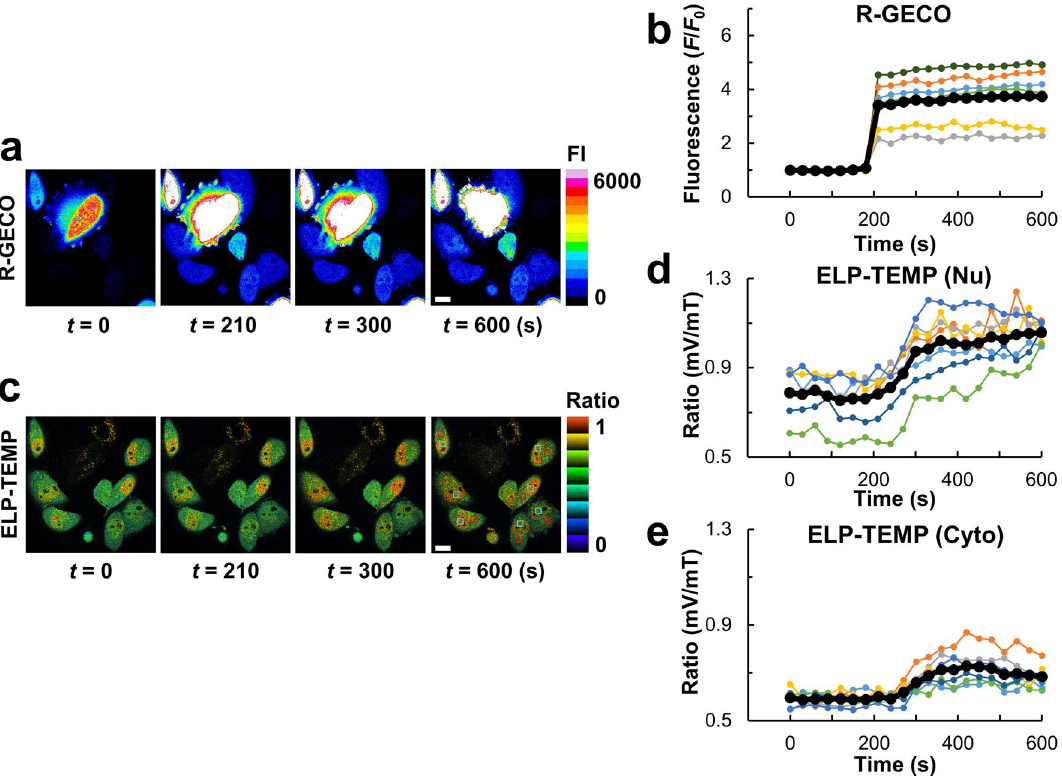
Figure 5. Visualization of heat production by stimulated Ca 2+ influx with a Ca 2+ -ionophore ionomycin in live HeLa cells stably expressing ELP-TEMP and transiently co-expressing R-GECO. ( a ) Pseudo-colored fluorescence images of R-GECO in response to ionomycin stimulation. ( b ) A plot of fluorescence intensity ( F / F 0 ) of R-GECO against time. ( c ) Pseudo-colored ratio images of ELP-TEMP in response to ionomycin stimulation. ( d ) A plot of fluorescence ratio mV/mT of ELP-TEMP in the nuclues (Nu) against time. ( e ) A plot of fluorescence ratio mV/mT of ELP-TEMP in the cytoplasm (Cyto) against time. The observation was performed under the same confocal micoscope in Fig. 3. To prevent changes in medium temperature due to ionomycin stimulation, medium containing 4 µM ionomycin was supplied through a preheated perfusion tube, and the medium temperature around the observed cells was maintained at 34 ± 0.1 °C during observation. Red and cyan squares indicate ROIs for cytoplasm and nuclues, respectively. The color bars indicate fluorescence intensity (FI) and ratio for ( a ) and ( c ), respectively. Scale bars, 20